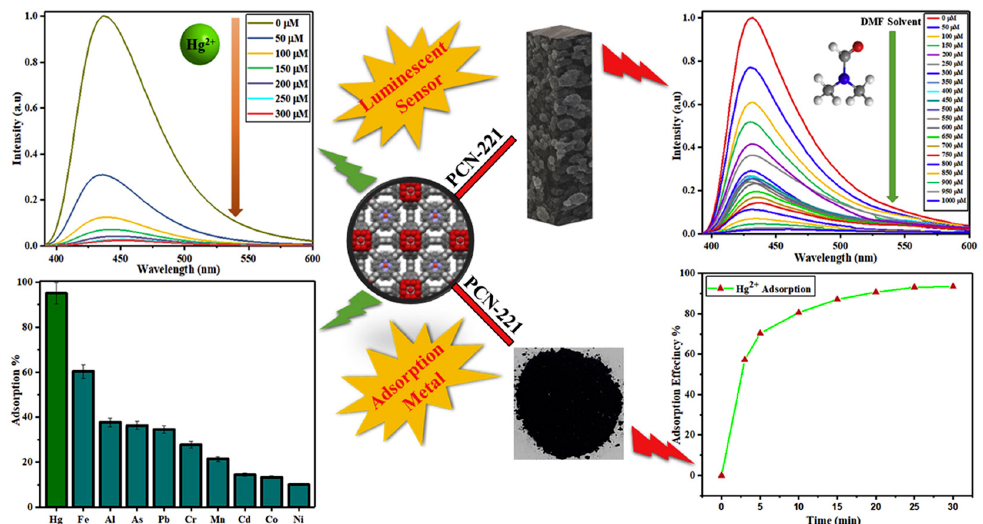
Figure 14. Porphyrinic zirconium-based MOF as an efficient fluorescence sensing for Hg 2+ ions and DMF small molecule. Reprinted with permission from ref [62]. Copyright 2020 Elsevier Inc. All rights reserved.